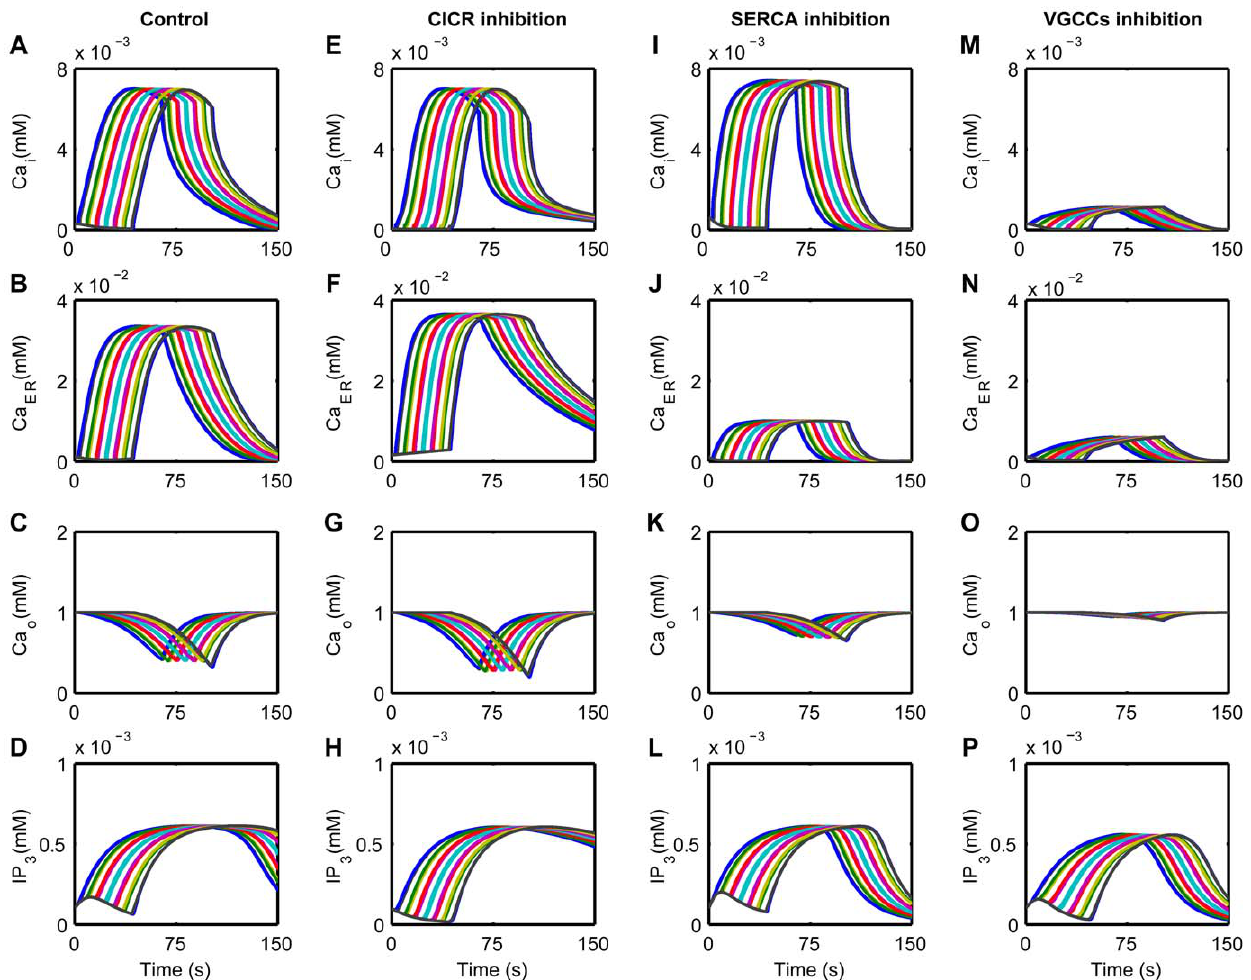
Figure 4. The influence of different Ca 2 + flows on CSD-triggered Ca 2 + waves (CSDCWs). A typical CSDCW is characterized as the significant elevation of Ca 2 + in the ICS at successive astrocytes in the network (A), associated with the increase of Ca 2 + in the ER (B), the increase of IP 3 in the ICS (D) and the decrease of Ca 2 + in the ECS (C). CICR inhibition shortens the duration of increased Ca 2 + in the ICS (E), slows the recovery of Ca 2 + in the ER (F), decreases Ca 2 + in the ECS more than in the control condition (G) and increases the duration of increased IP 3 in the ICS (H). SERCA inhibition increases the amplitude of Ca 2 + in the ICS (I) and decreases that in the ER (J). Ca 2 + in the ECS is increased compared to the control (K). Because high Ca 2 + in the ICS would inhibit the process of CICR, the increase of IP 3 in the ICS is shortened (L). After VGCCs inhibition, Ca 2 + is largely weakened in the ICS (M), in the ER (N) and in the ECS (O). The changes of IP 3 are also shortened because of the low Ca 2 + in the ICS (P).